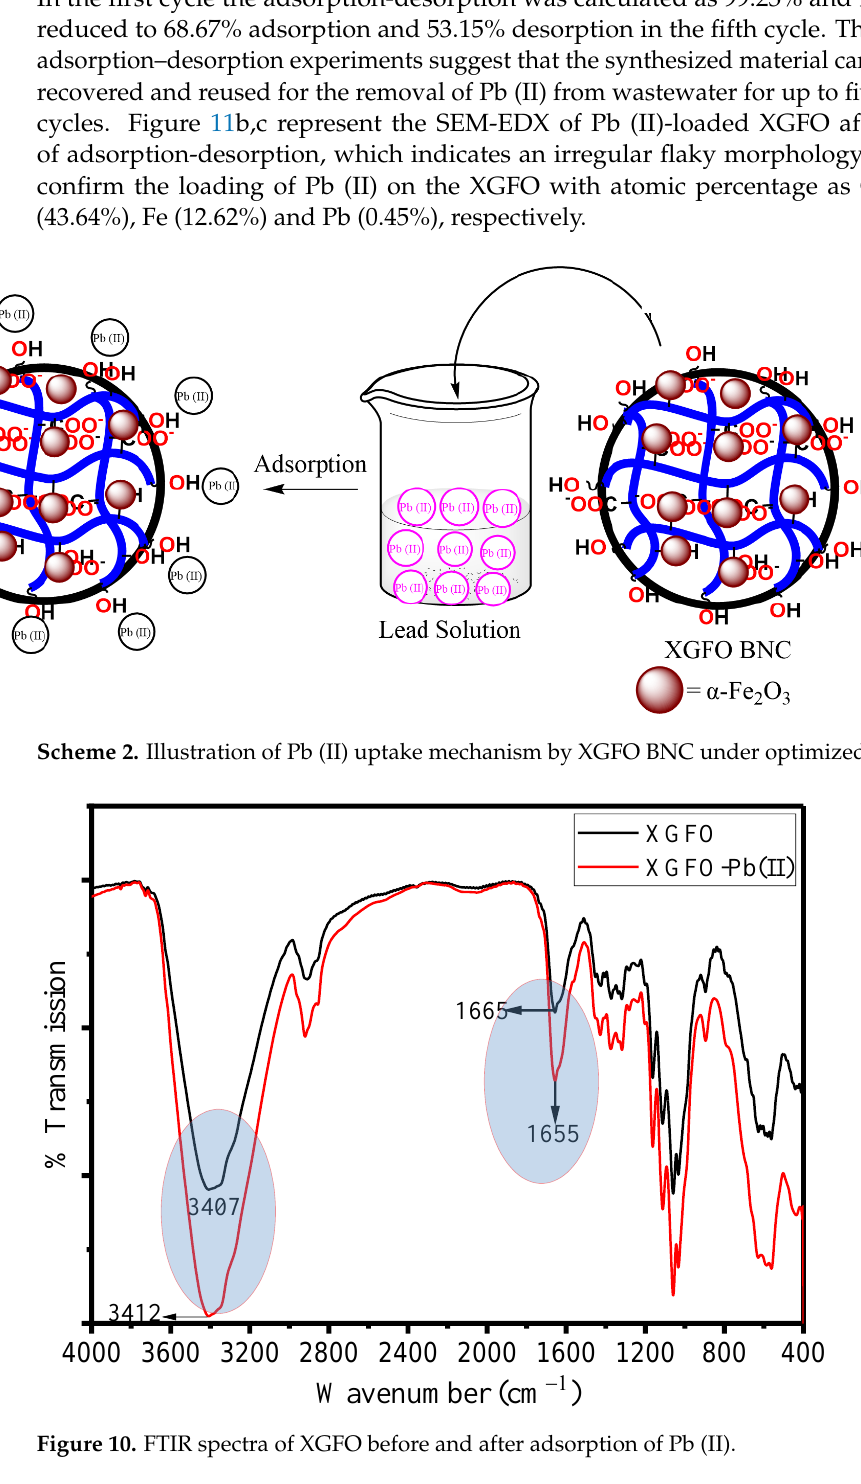
Figure 10. FTIR spectra of XGFO before and after adsorption of Pb (II).